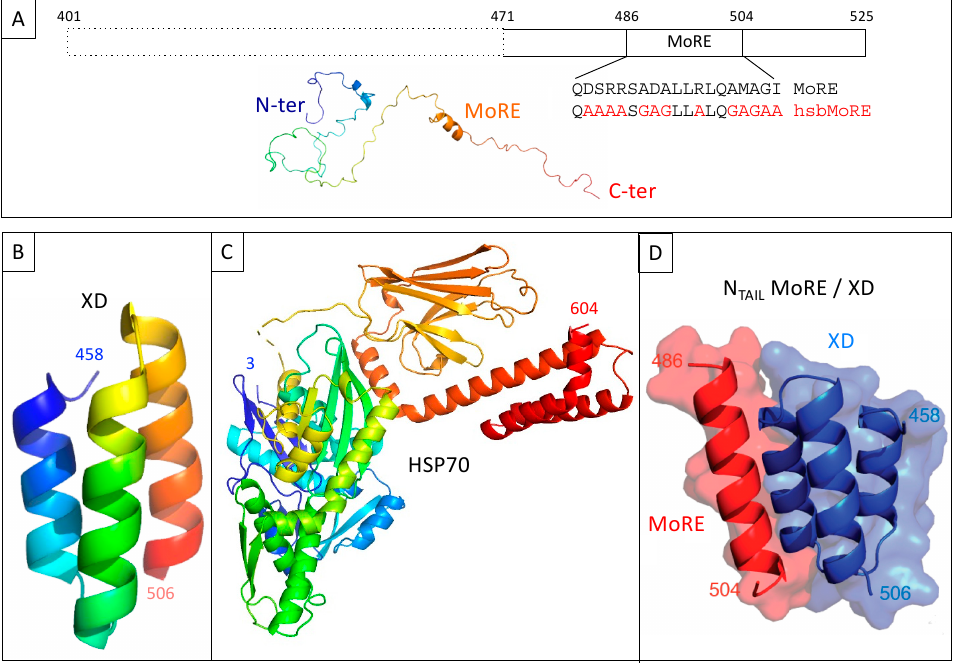
Figure 2. ( A ) Schematic representation of measles virus N TAIL ( upper panel) and cartoon representation of an N TAIL conformer generated using Flexible-Mecano [22]. ( B ) Ribbon representation of the crystal structure of measles virus XD (PDB code 1OKS). ( C ) Cartoon representation of the crystal structure of HSP70 based on pdb codes 1HJO and 4JNF. The relative orientation of the two hsp70 domains (i.e., amino acids 3–382 and amino acids 389–610) is based on the structure of a form encompassing residues 1–554 (pdb code 1YUW). ( D ) Structure of the complex between measles virus XD (blue) and of the MoRE of N TAIL (red, aa 486–504) (PDB code 1T6O). The buried surface area of the XD/MoRE complex is 634 Å 2 .